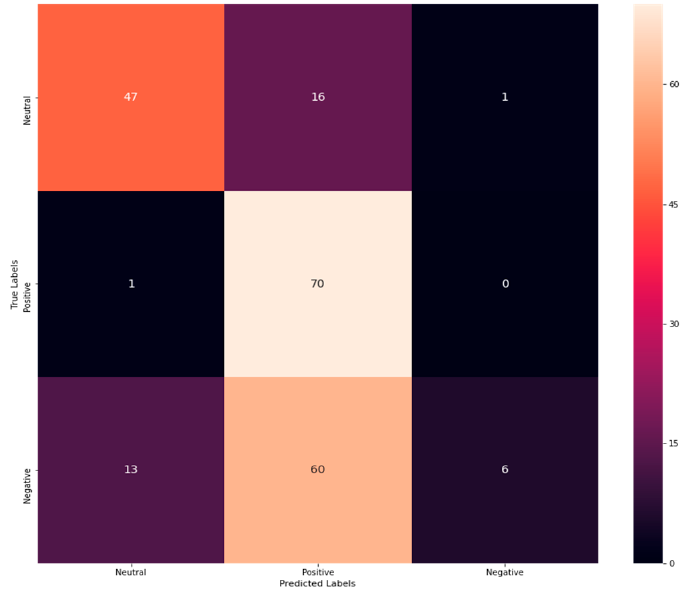
Figure 3. Confusion matrix of NB. Table 3. Analysis of Decision Tree.